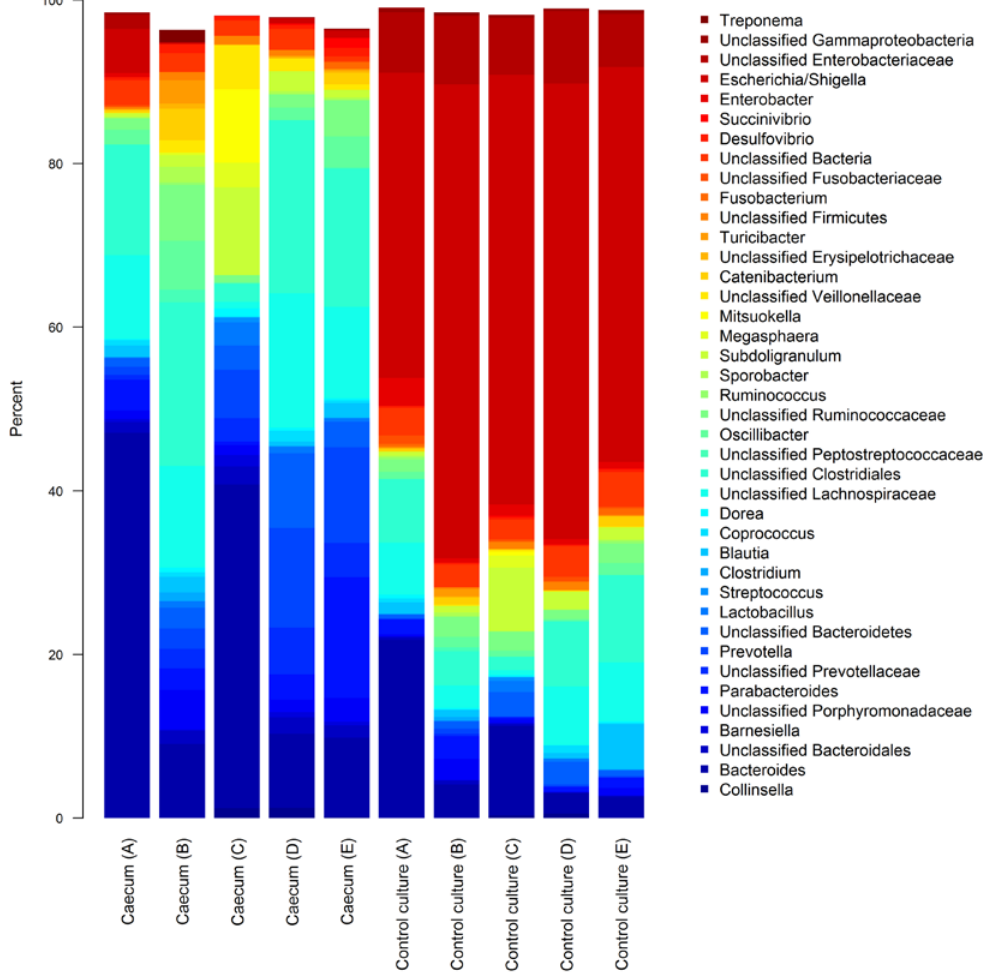
Figure 1. Stacked barplots showing genus level composition of fresh piglet caecal community (Caecum) and caecal contents cultured in basal mineral medium (Control culture). Letters in parentheses identify the piglet source for caecal contents. The bacteria shown are the 40 taxa with the highest mean relative abundance across all